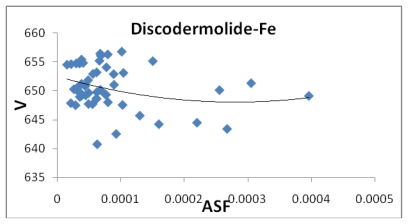
The volume (Å3) plotted against the aqueous stability factor (Jm/D) for discodermolide bound to iron only. The best fit equation for the data set is the polynomial y = 6*107x2 − 31647x + 652.51 (R2 = 0.0749).